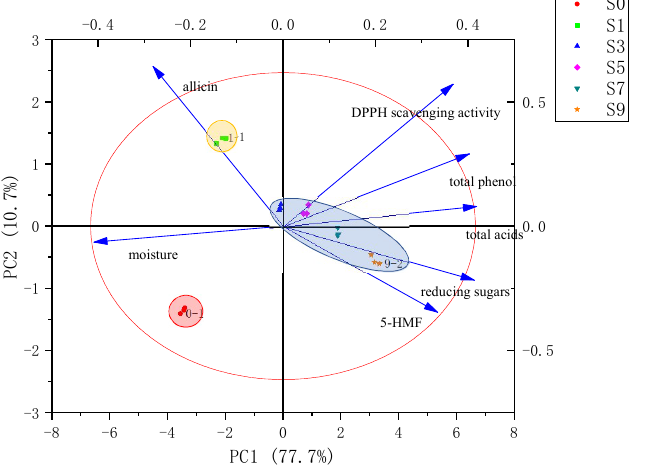
Figure 4. Principal component analysis based on the contents of main components in black garlic at different processing times. The biplot describes the evolution of garlic during fermentation and the contribution of compounds to the variability among samples.